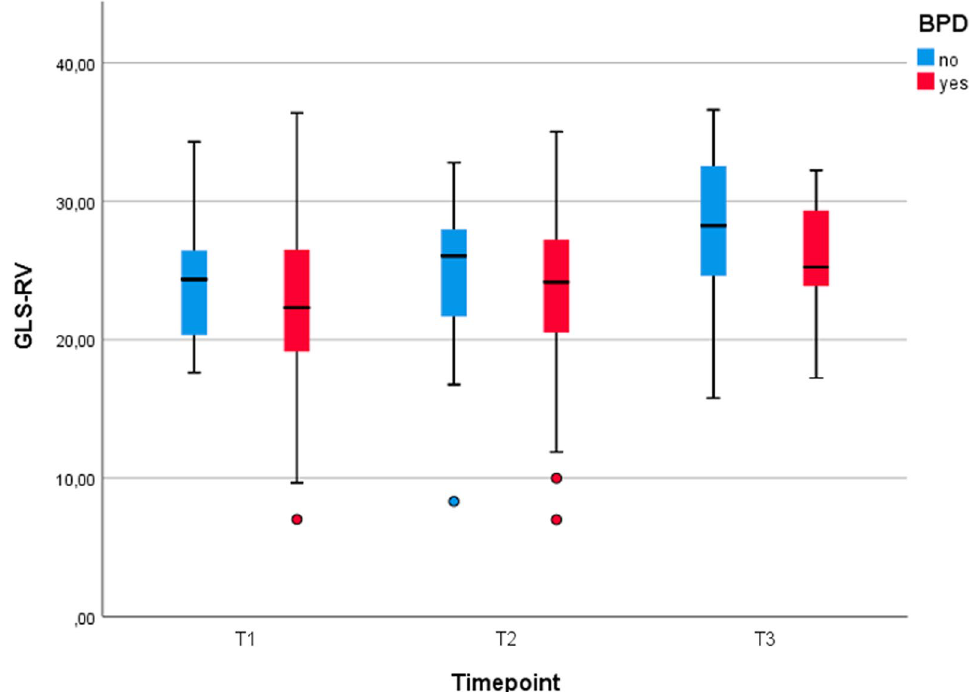
Fig. 3 GLS‑RV (mean and standard deviation) at different timepoints. Although it is no significant, we can appreciate that GLS‑RV tends to improve along time, which is more evident in BPD